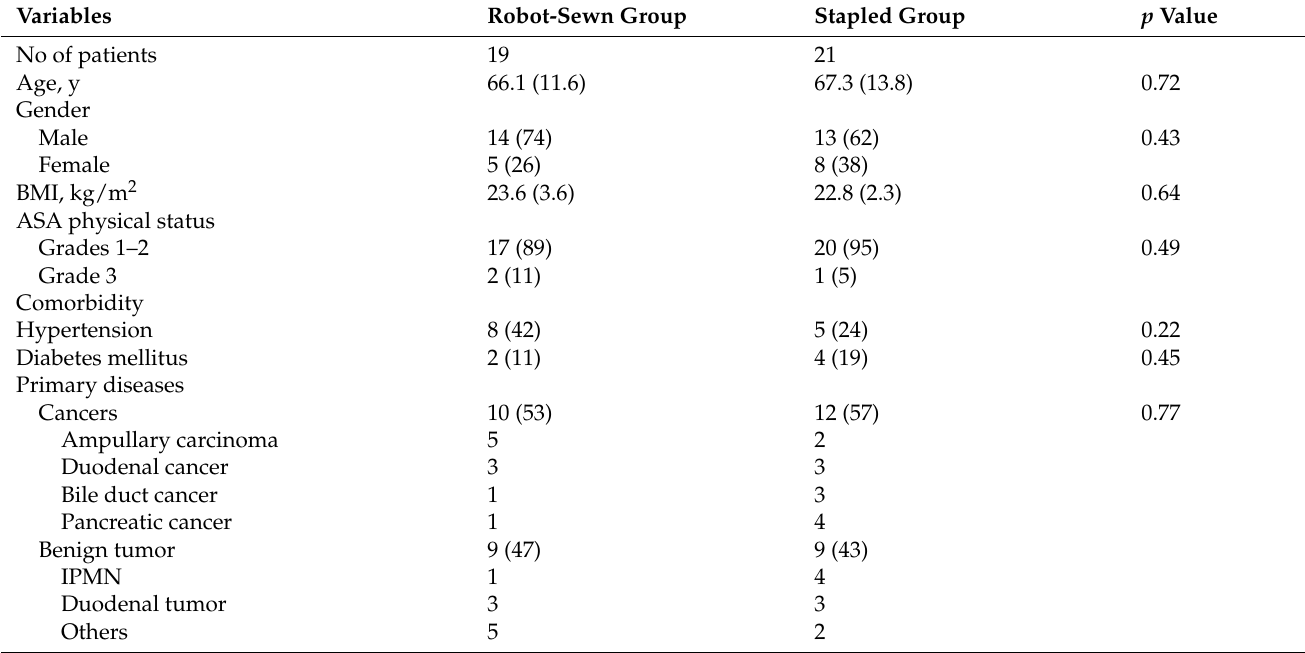
Table 1. Characteristics between robot-sewn and stapled gastrojejunostomy anastomosis in robotic